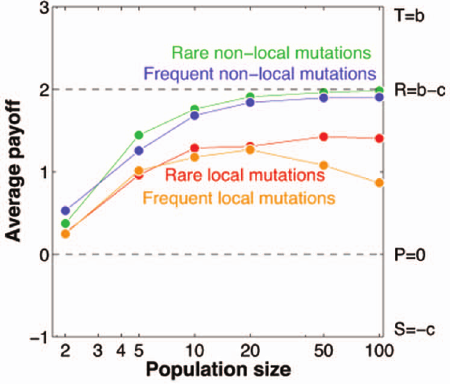
Figure 5. Average payoffs for the four different mutation treatments. In rare-mutation treatments, the mutation rate is set to m ~ 0 : 001 , whereas in frequent-mutation treatments the mutation rate is m ~ 0 : 05 . Local mutations are randomly drawn from a Gaussian distribution around the parent strategy, non-local mutations are randomly drawn from the entire state space. The rare local mutations correspond to the previous simulations in Figs. 3 and 4. All other parameters are the same as